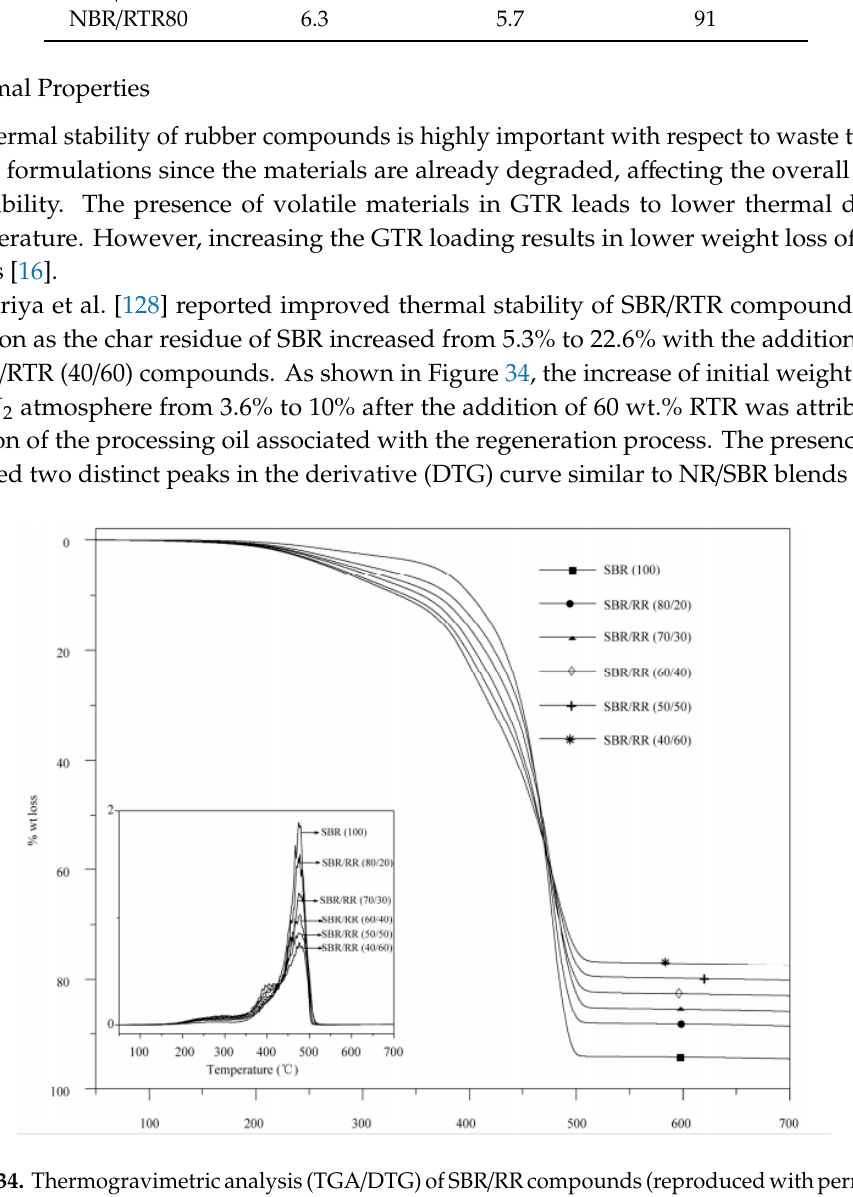
Figure34. Thermogravimetricanalysis(TGA / DTG)ofSBR / RRcompounds(reproducedwithpermission Figure 34. Thermogravimetric analysis (TGA/DTG) of SBR/RR compounds (reproduced with from permission from [128]).